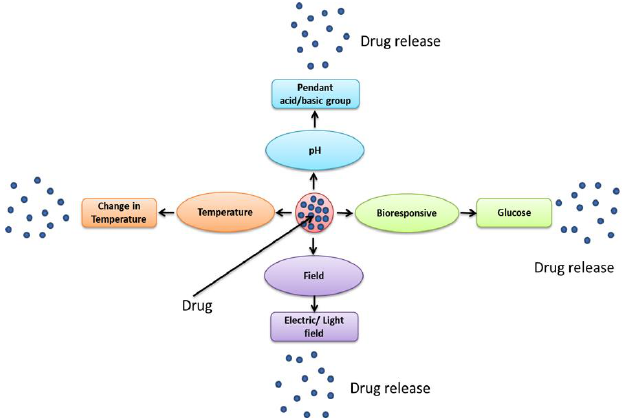
Figure 1. Different types of smart polymeric drug delivery systems for controlling drug release.